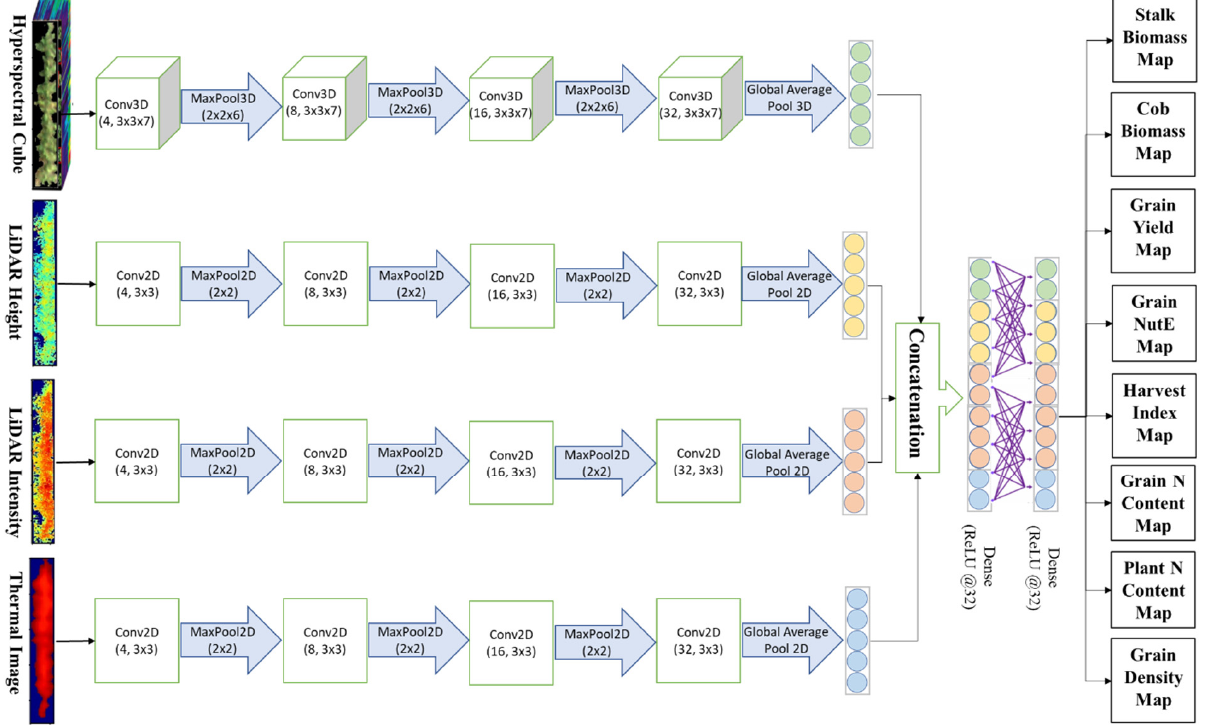
Figure 6. Multimodal fusion and multi-task deep learning scheme simultaneously predicting all of the maize phenotypes. Each stream of convolutional layers automatically processed a different data modality prior to being fused and fetched to multi-task regressors.